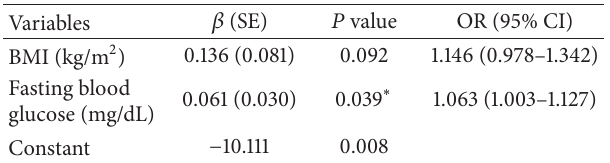
Table 5: Model for predicting abnormal motor nerve function (Model 1).